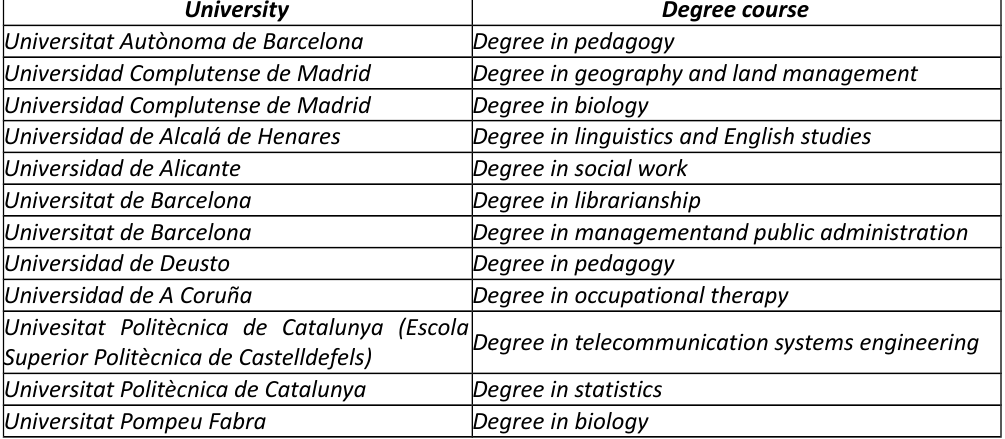
Table 1. List of degree courses that collaborated on this